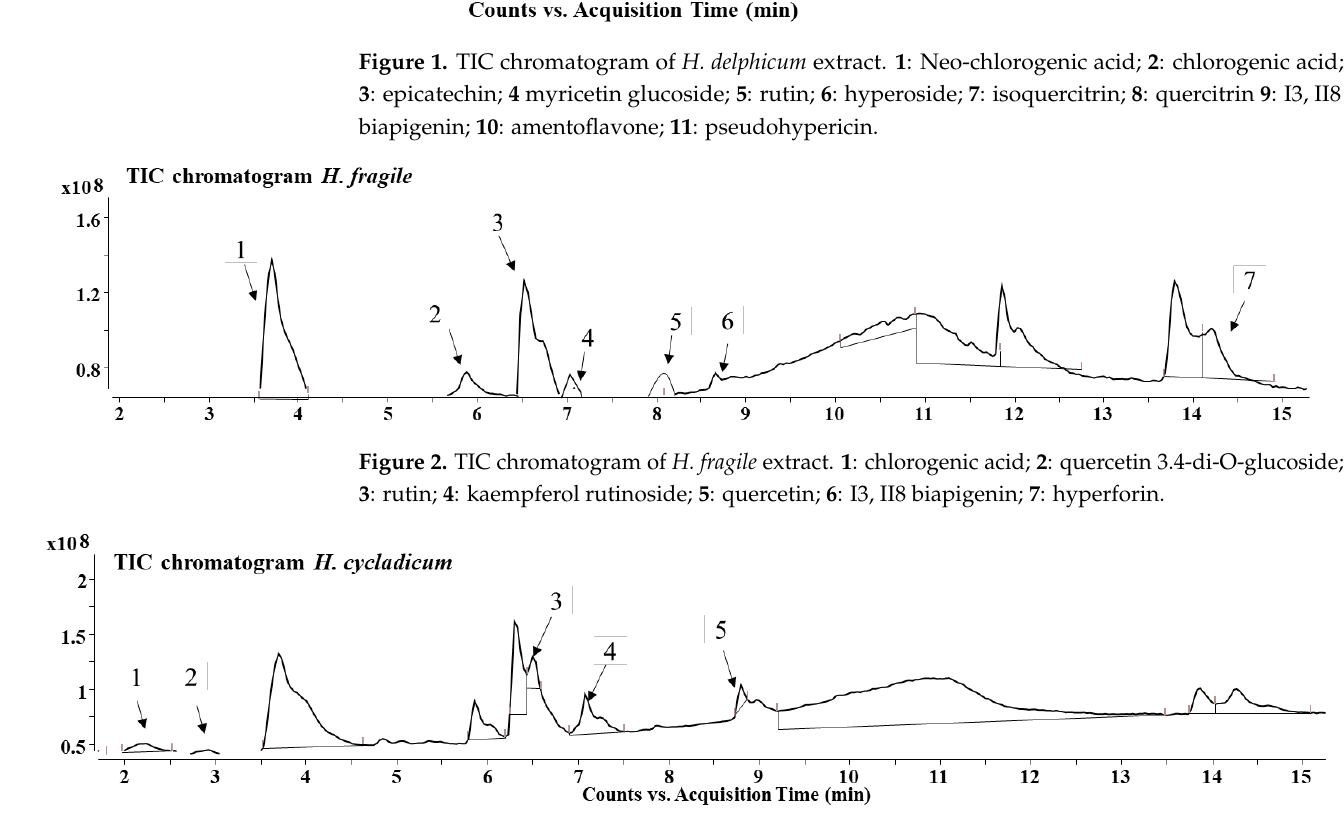
Figure 3. TIC chromatogram of H. cycladicum extract. 1 : neo-chlorogenic acid; 2 : procyanidin B-type; 3 : rutin; 4: kaempferol glucoside; 5 : I3, II8 biapigenin. Table 2. Antioxidant activity of Hypericum spp. extracts by DPPH and ABTS